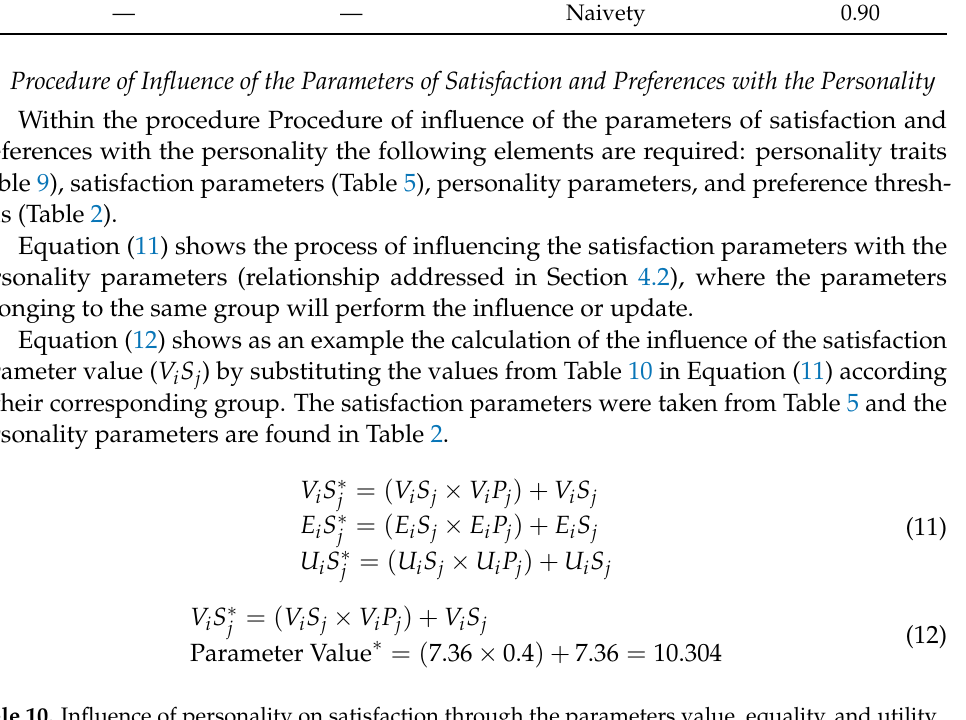
Table 10. Influence of personality on satisfaction through the parameters value, equality, and utility. Params. ( i ) Satisf. Params. ( S j ) Pers. Params. ( P j